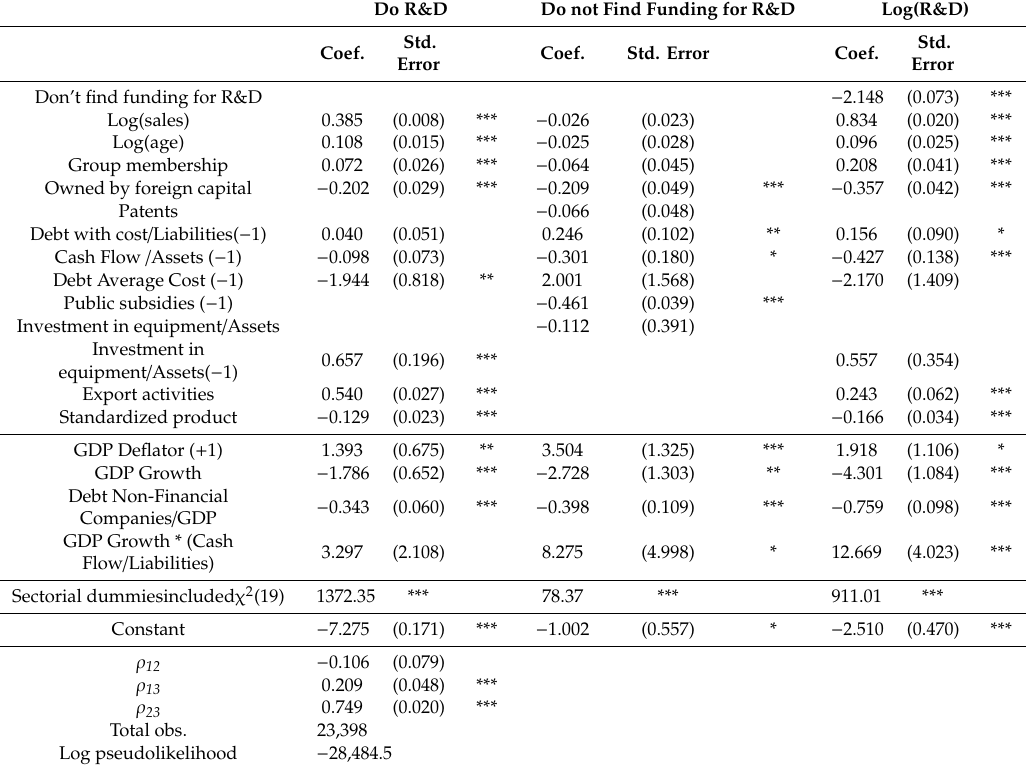
Table 2. Simultaneous mixed-process regression: model with macroeconomic variables.